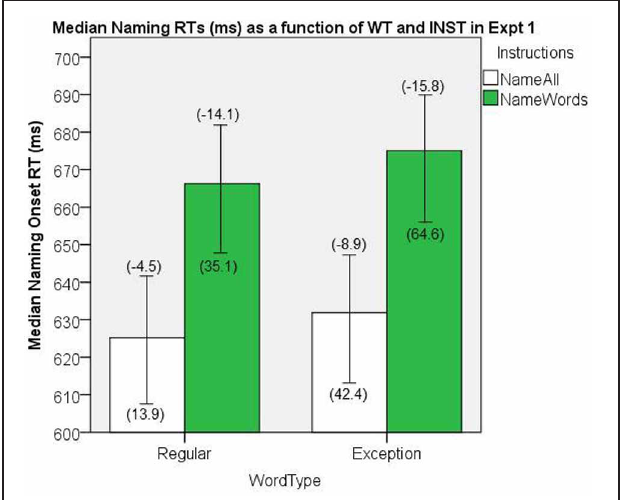
FIGURE 6 | Median Naming RTs (in ms) as a function of WT and INST in Experiment 1. The 95% C.I.s are presented as error bars using Loftus and Masson’s (1994) method. Co-efficients relating WF to RT (ms/log 10 HALWF) are presented in parentheses above each error bar, and co-efficients relating SND to RT (ms/unit inverseNcount) are presented in parentheses below each error